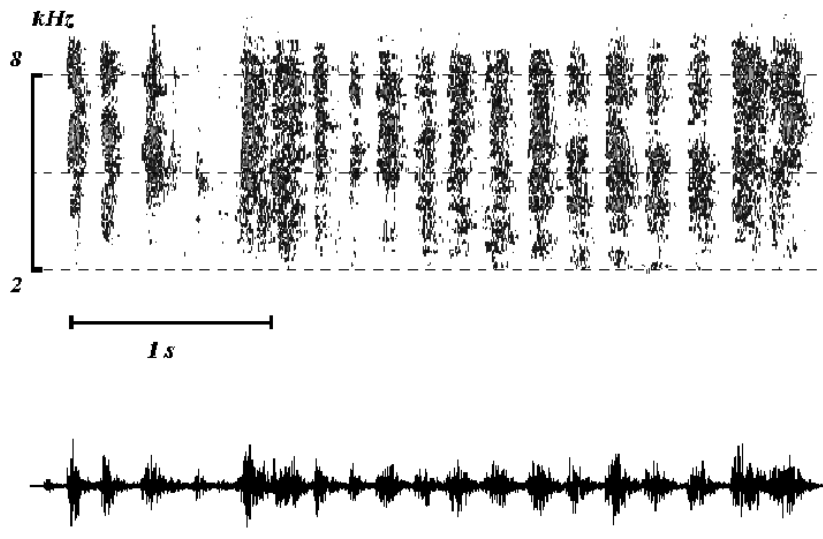
Fig. 1 – Sonogram and oscillogram of an alarm call (AL) of a Budgerigar Melopsittacus undulatus , used in the